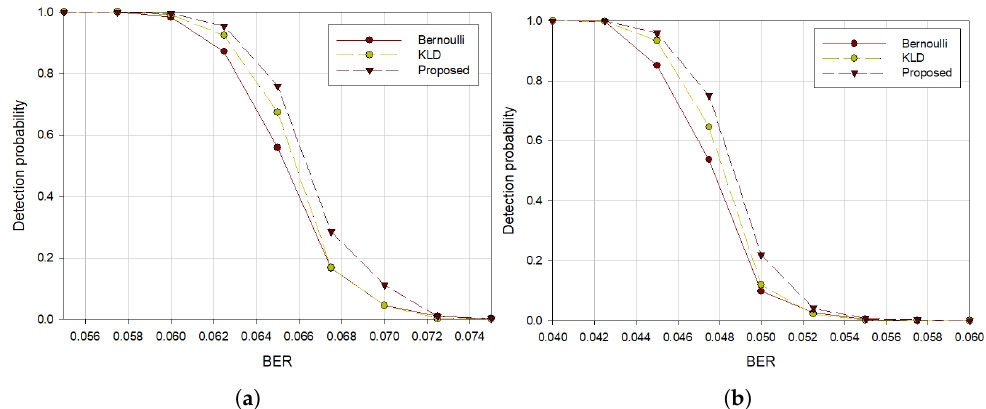
Figure 5. Detection probability with ( a ) BCH(15,5) code, ( b ) BCH(15,7) code when S = 30.